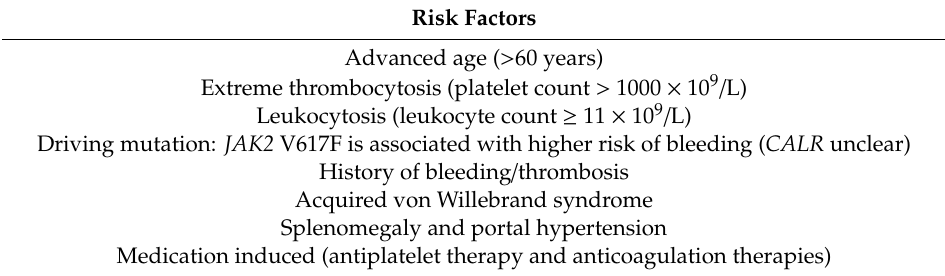
Table 3. Risk factors for bleeding in patients with essential